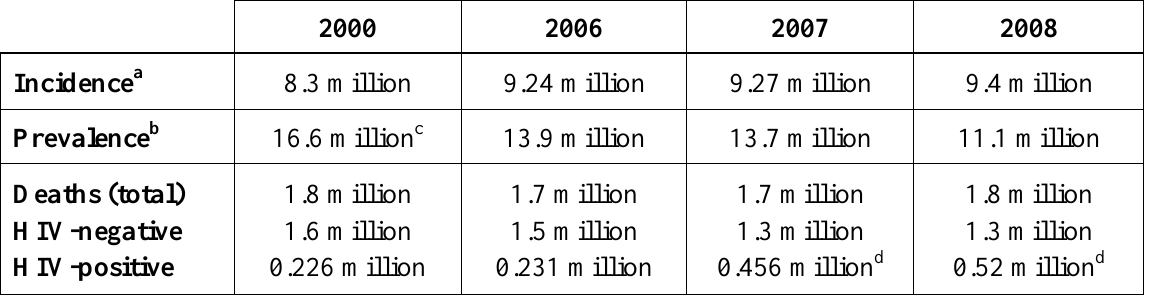
Table 1. Estimated global incidence, prevalence, and mortality of TB